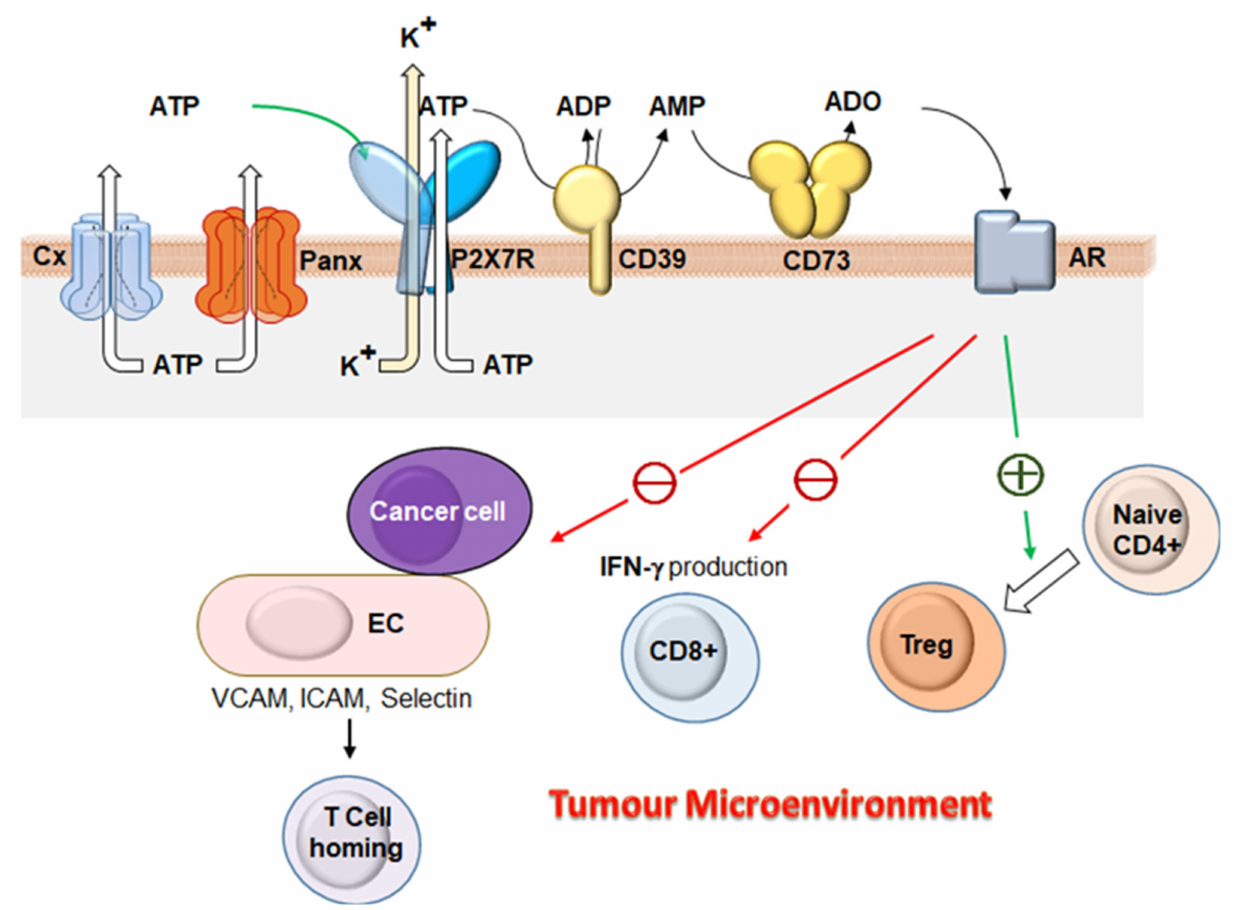
Figure 2. The Panx/purinergic system role in cancer facilitation. ATP is released into the extracellular space via different modalities, among which relevant to this review, Panx1-HCs, or P2XR7, amplifying the signal derived from ATP. P2XR7 is activated by extracellular ATP, that, in turn, activates P2X7R to trigger K+ efflux. Released ATP is hydrolyzed to ADP and AMP by ectonucleotidase such as CD39. AMP is further degraded to adenosine (ADO) by CD73 and activate adenosine receptors (AR). CD39 and CD73 are expressed not only by tumor stromal cells (such as endothelial cells or tumor-associated regulatory T cells) but also by certain cancer cells. Adenosine exerts its immunosuppressive effects by activating AR expressed by tumors cells, endothelial cells (EC), or immune cells, then acting in paracrine and autocrine way. Due to the activation of A2A adenosine receptors, an inhibition of IFN- γ production and cytotoxic killing by CD8+ T cells and promotion of CD4+ cells differentiation into T-regulatory cells occur. ADO also acts on the tumor-surrounding endothelium repressing T-cell homing to tumors via downmodulation of adhesion proteins such as ICAM-1, VCAM-1, or P-selectin on